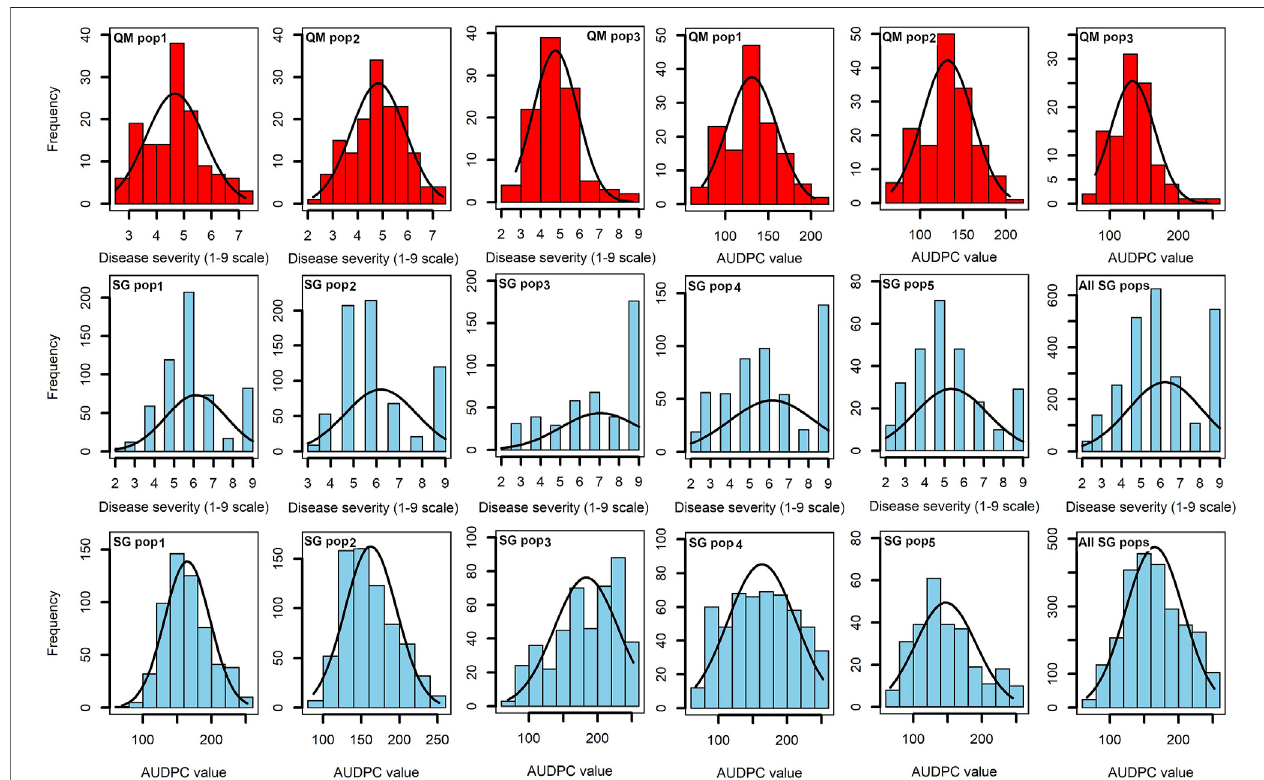
FIGURE1| PhenotypicdistributionofMLNdiseaseseverity(onascaleof1 – 9)andAUDPCvaluesinthreeQMpopulations(inred)and fi veSGpopulations(inblue).